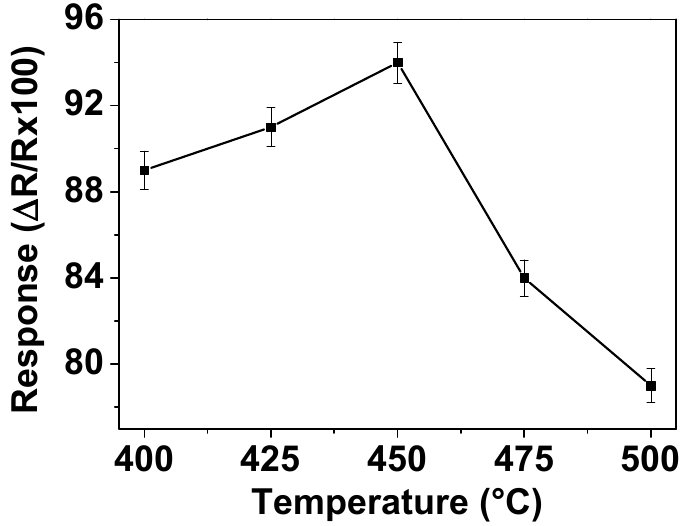
Figure 3. Response of gas sensor based on ZnO thin film to 200 ppm of NO 2 at different operating temperatures in dry air.